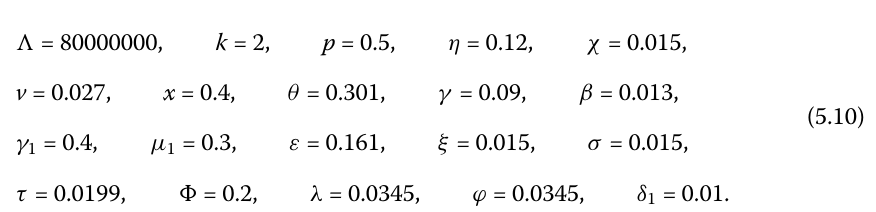
Also the parameters